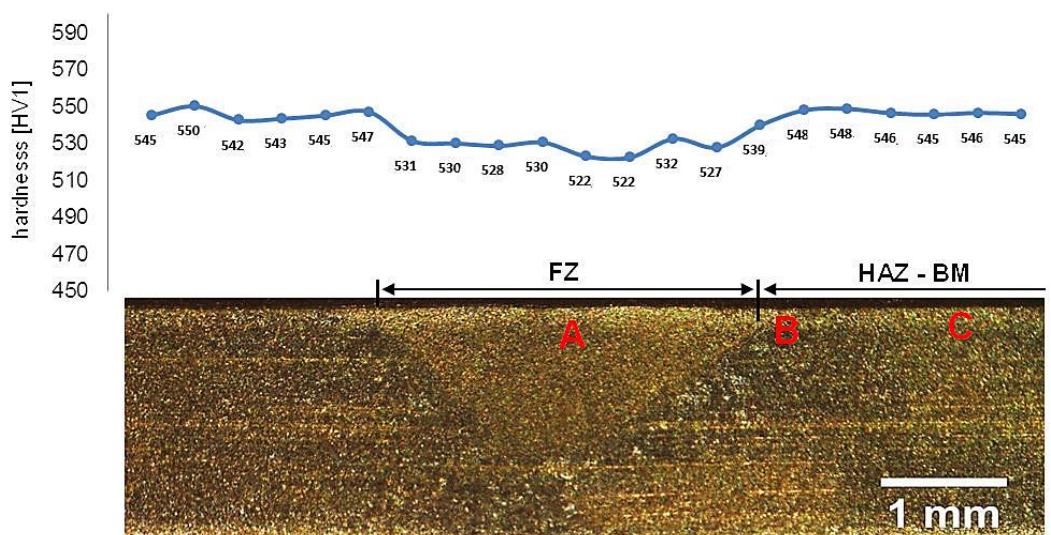
Figure 16. Macroscopic view of welded joint of 55Si7 steel after post welding heat treatment along with the hardness distribution and areas of structural investigations. Etched by saturated picric acid solution and nital, LM. Due to the character of the hardness distribution and the preliminary structure assessment, three areas were selected for further investigations: ( A ) corresponding to FZ, ( B ) corresponding to HAZ, and ( C ) corresponding to BM.